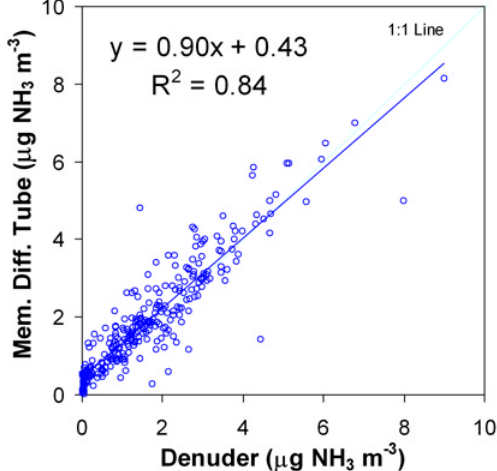
FIGURE 4. Comparison of individual monthly NH 3 concentrations from triplicate membrane diffusion tubes operated alongside an active denuder system, as part of the ongoing methods validation at nine sites in the DETR U.K. National Ammonia Monitoring